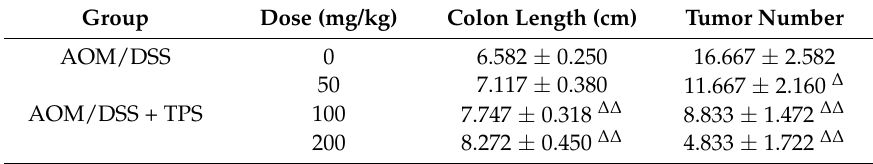
Table 1. Colon length and tumor number at the end of the